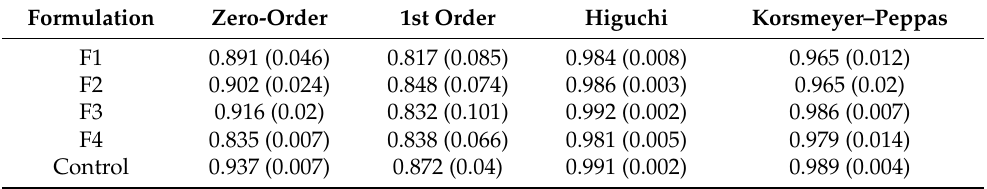
Values between brackets are SD ( n = 3).